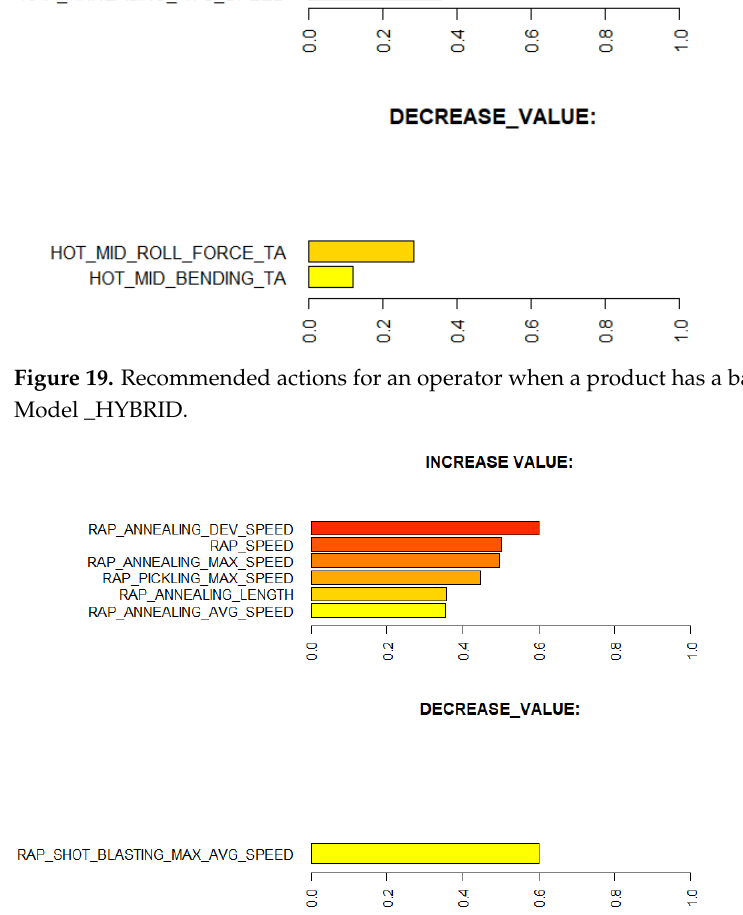
Figure 20. Recommended actions for an operator when a product has a bad predicted quality with Model